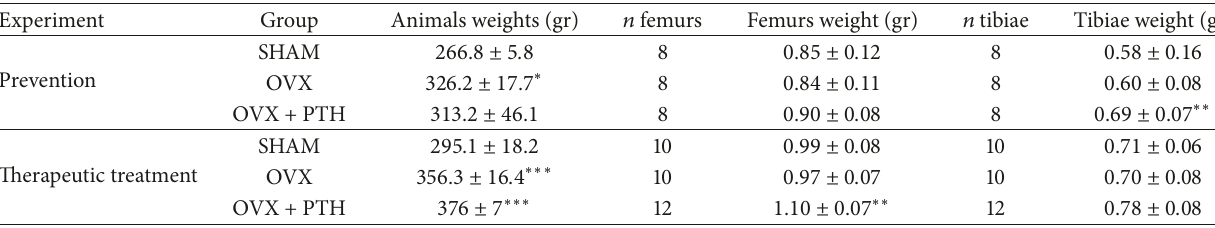
Table 1: Animals and bones average weights in the prevention experiment (6 weeks after operation) and in the therapeutic treatment experiment (11 weeks after